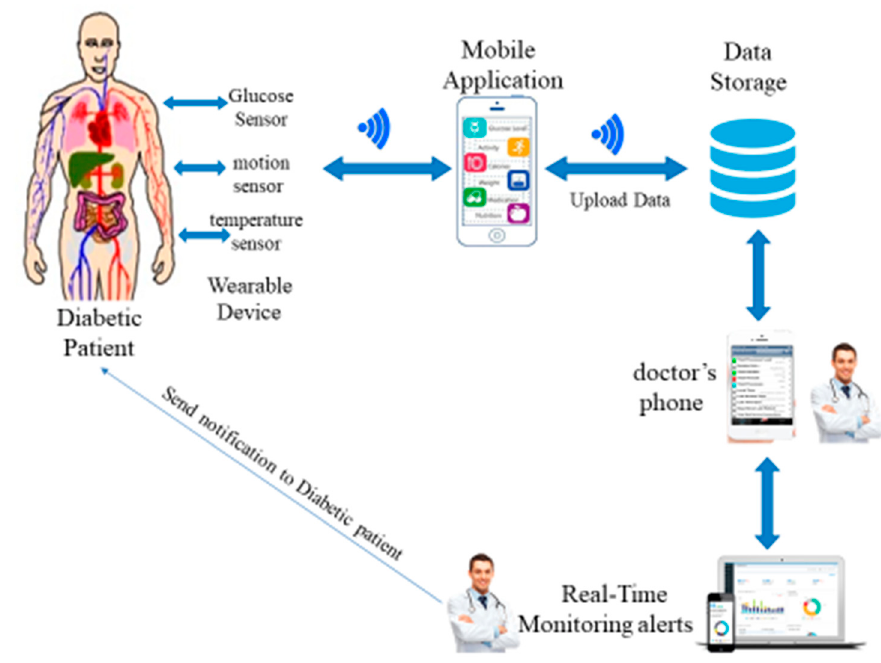
Figure 1. Proposed architecture for diabetic monitoring.